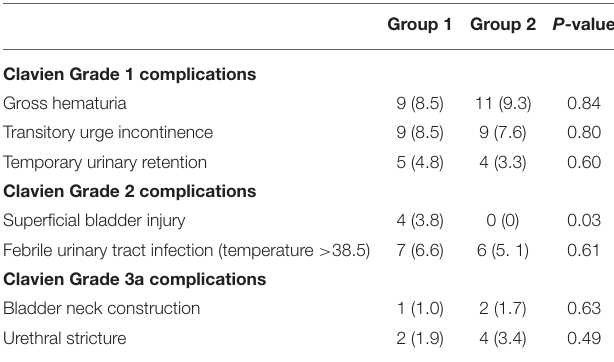
TABLE 4 | Adverse events in the 2